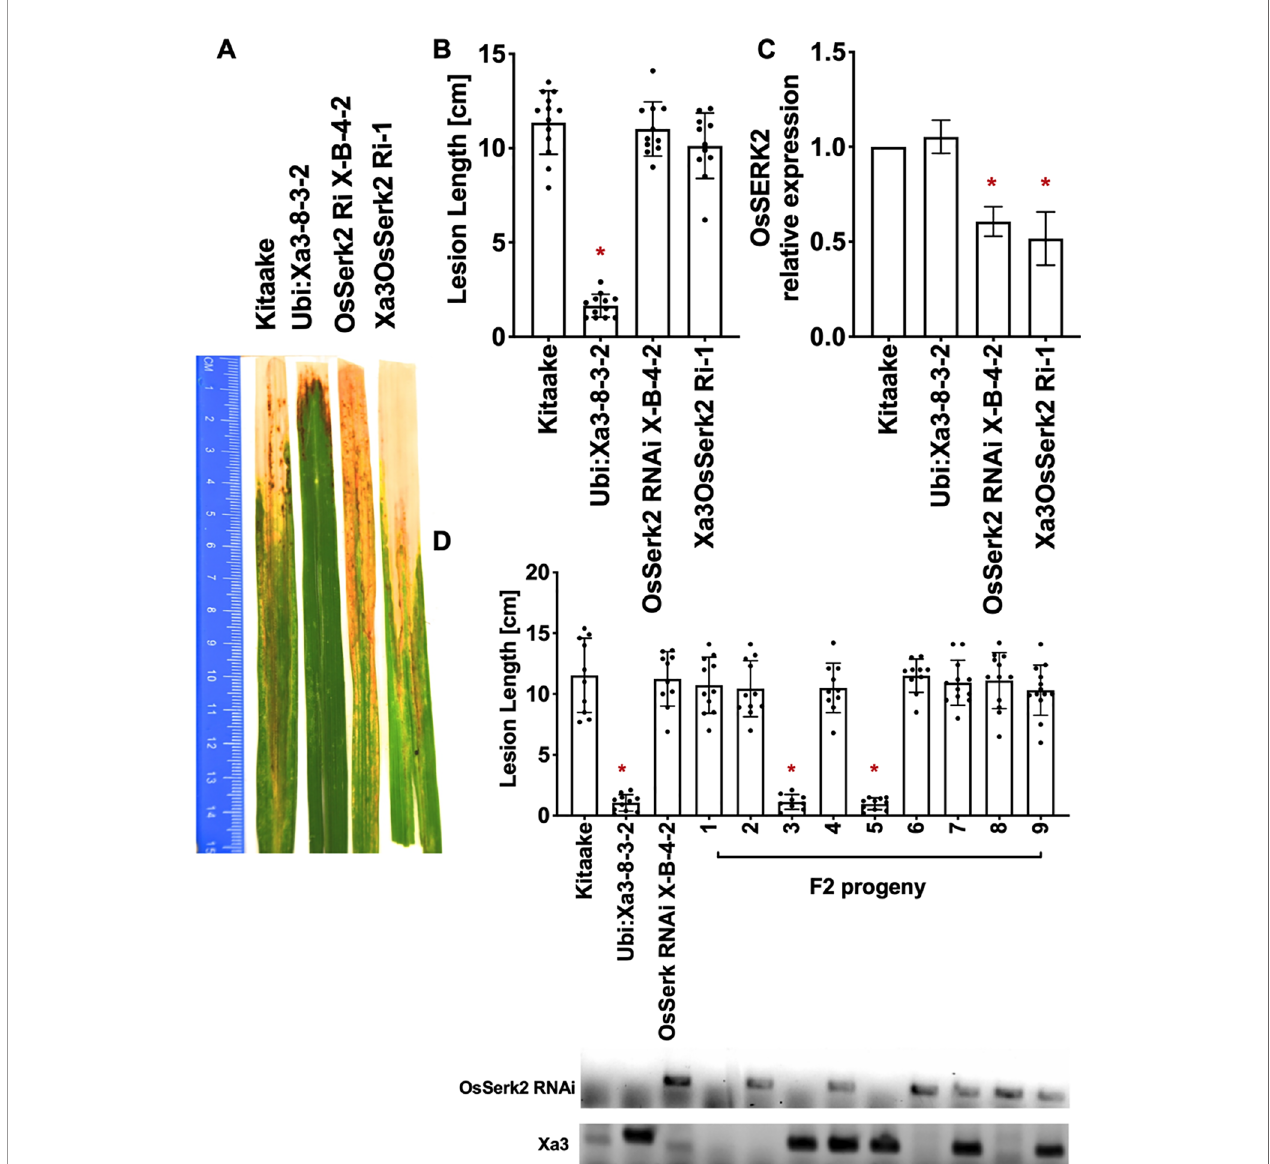
FIGURE 5 | OsSERK2 is required for XA3-mediated immunity in the Kitaake genetic background. (A) Photographed 14 days after inoculation with Xoo strain PXO79. The inoculation method was described in Figure 1 . Control lines used were Kitaake, Ubi : Xa3-8-3-2 and OsSerk2 RNAi X-B-4-2 . (B) The average lesion length data of the inoculated plants. Bars represent means of 8-12 leaves. “ * ” indicates a statistically signi fi cant difference from Kitaake using Dunnett's test ( a = 0.05). (C) The qRT-PCR result shows that OsSERK2 is silenced in the inoculated F1 plant ( Xa3OsSerk2 Ri-1 ). Gene expression measurement is the average of three biological replicates. “ * ” indicates a statistically signi fi cant difference from Kitaake using Dunnett's test ( a = 0.05). (D) The average lesion length data of the inoculated F2 segregating population. Kitaake, Ubi : Xa3-8-3-2 and OsSerk2 RNAi X-B-4-2 were used as control lines. Bars represent means of 8 – 12 leaves. “ * ” indicates a statistically signi fi cant difference from Kitaake using Dunnett's test ( a = 0.05). PCR genotyping for the OsSerk RNAi construct and Xa3 transgene are shown below the bar